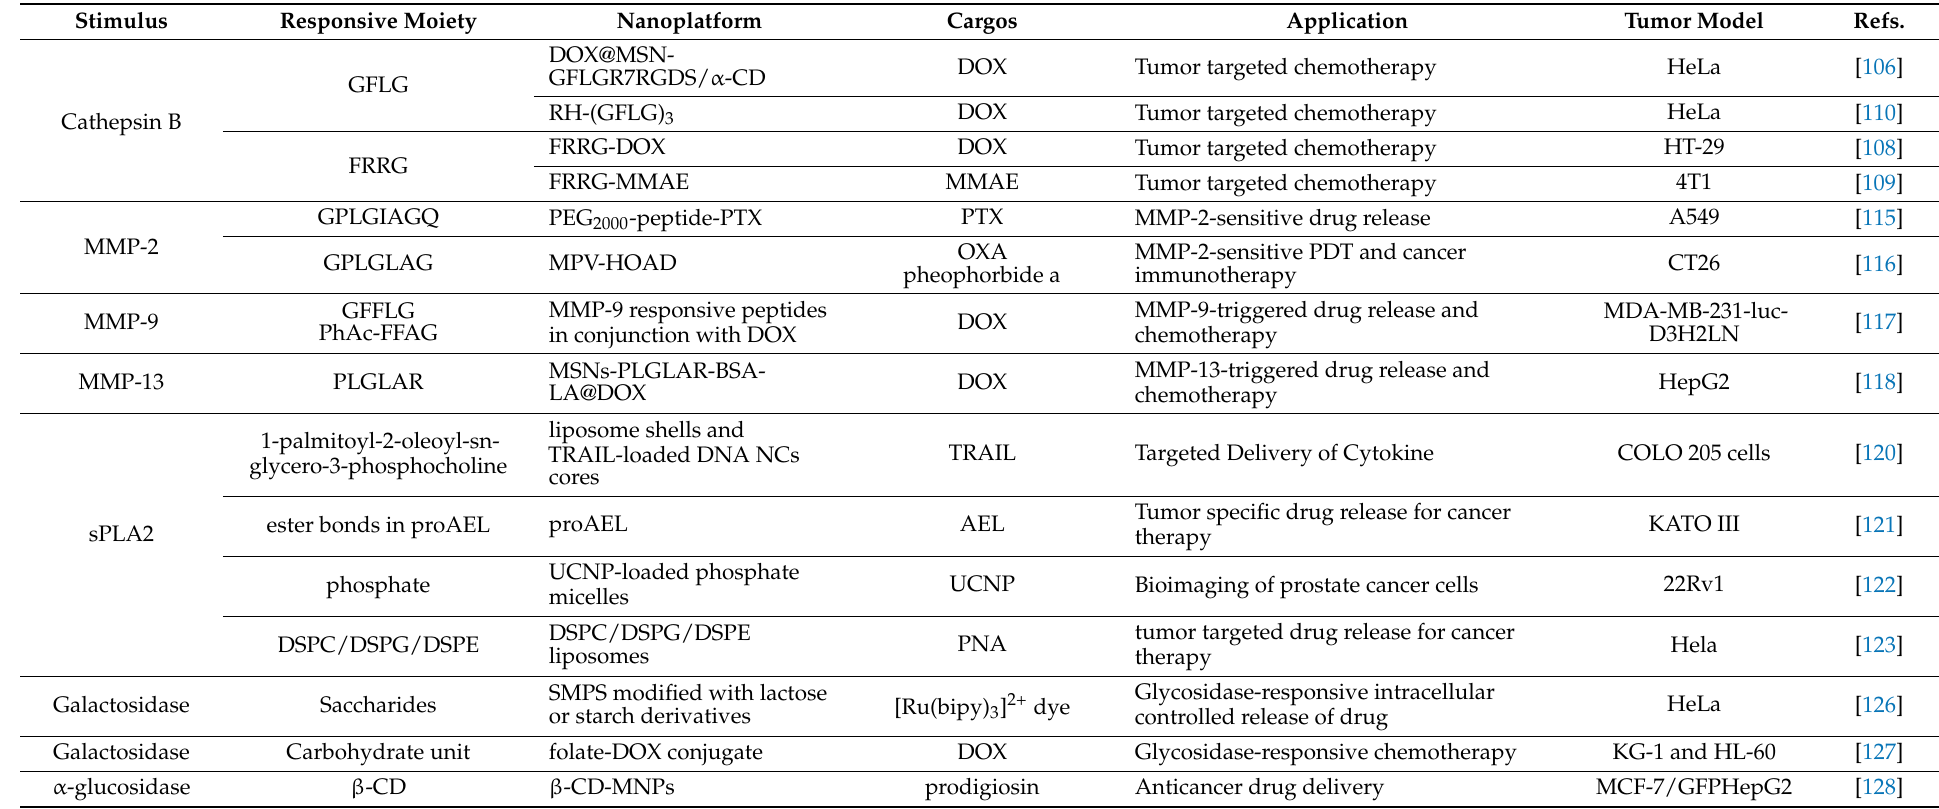
Table 2. Enzyme-responsive srNPs in cancer